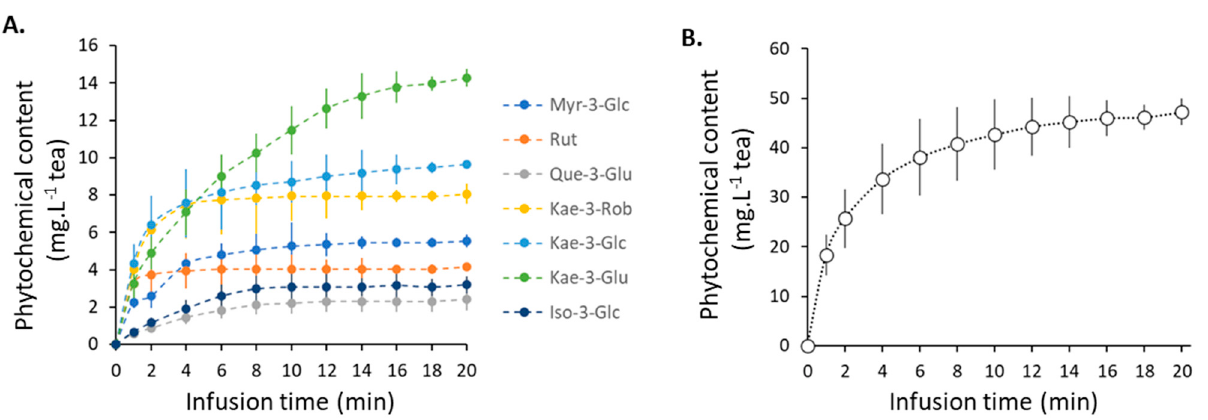
Figure 2. Kinetics of the main individual flavonoids ( A ) and total flavonoids ( B ) from sacred lotus stamen tea